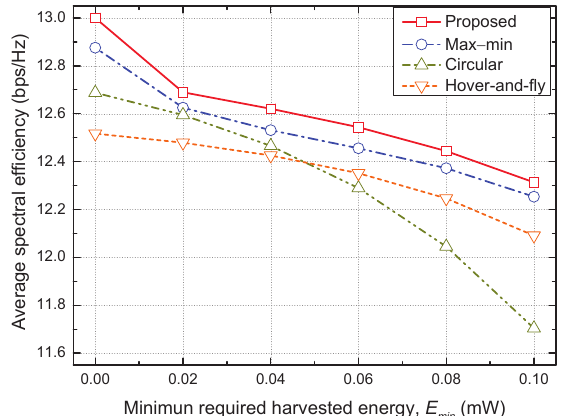
Figure 6. Average spectral efficiency vs. minimum required harvested